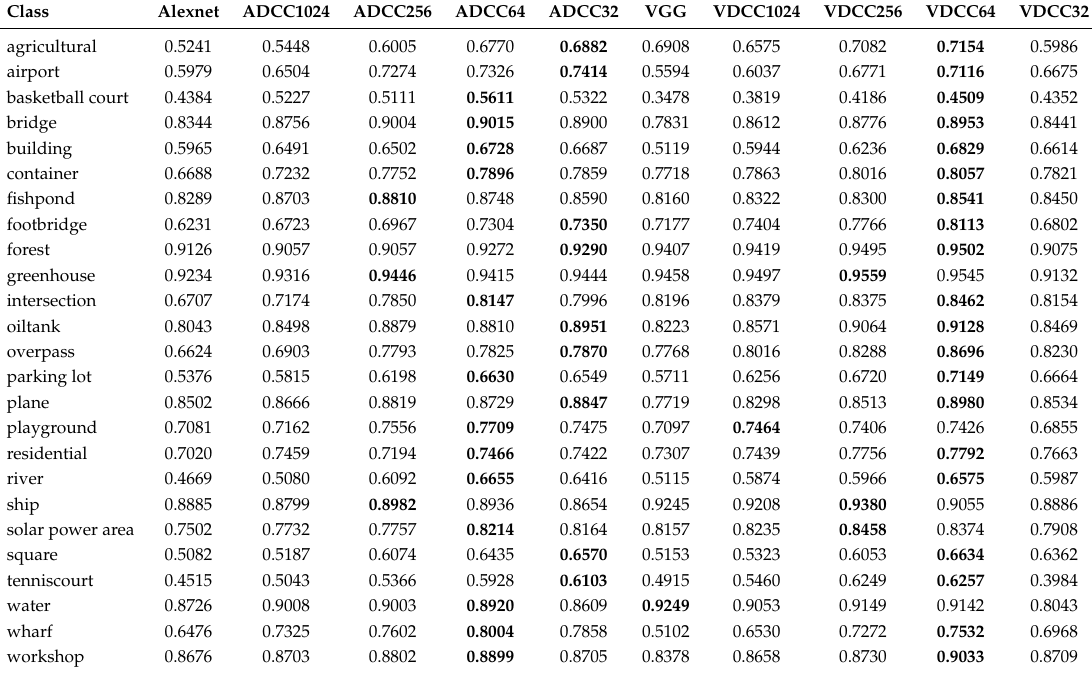
Table 1. P@100 values obtained using the models based on the Alexnet, VGG and corresponding DCC